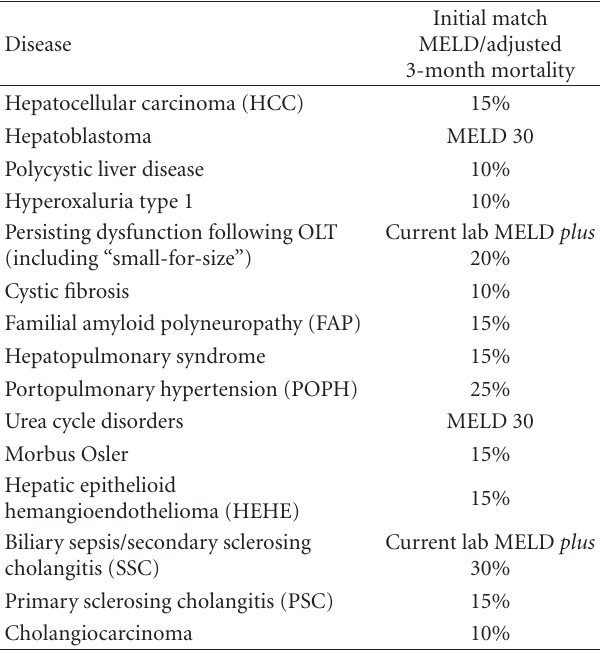
Table 1: Standard MELD exceptions in Germany and their adjusted MELD score or adjusted 3-months-mortality, respectively